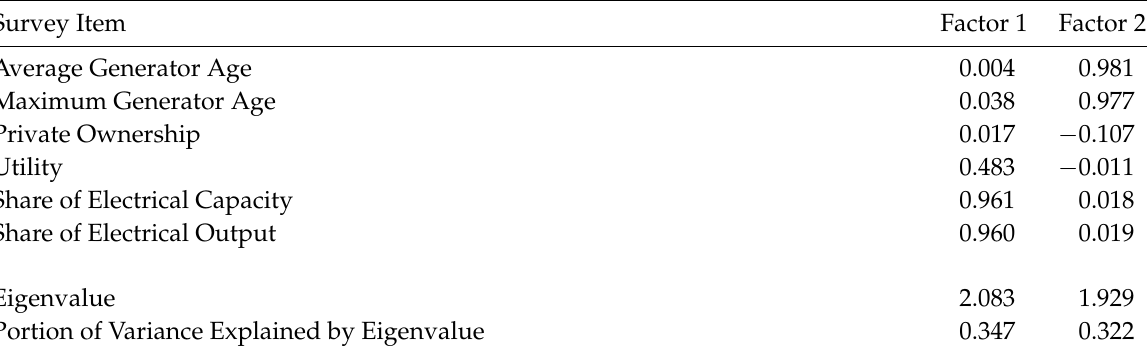
Table 4: Principal component factor analysis of organizational